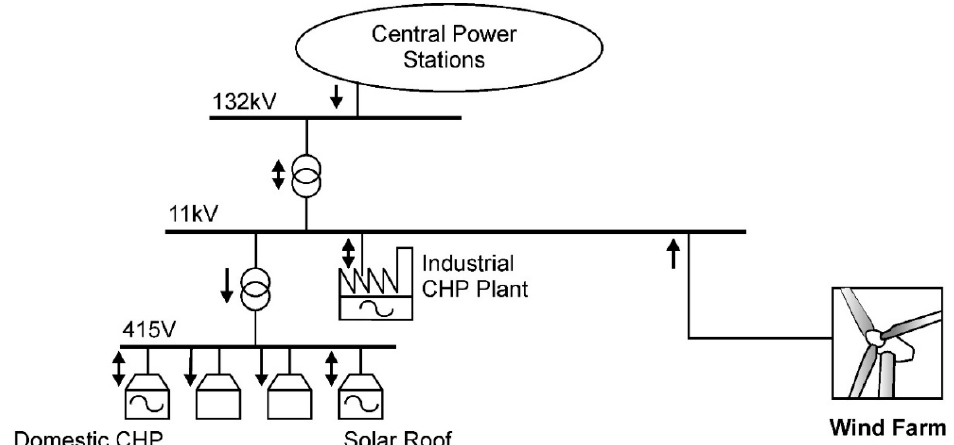
Figure 1. A schematic representation of a possible grid-connected ‘distributed generation’ network. The arrows represent the direction of electricity flows. Source: Reprinted with permission from Ref. [11]. 2008, UK Inst. Mech. Eng ./SAGE.